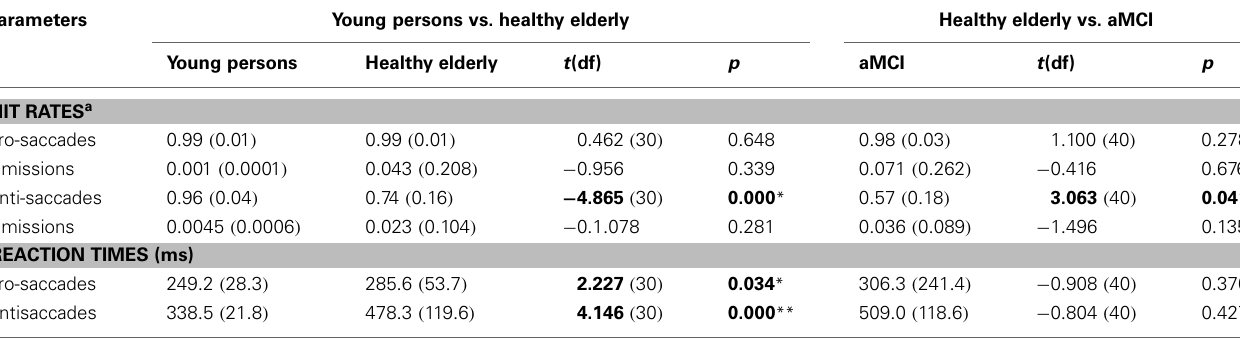
Table 3 | Performance measured outside of the scanner (proportion correct among executed saccades, proportion of omissions, reaction times in ms) of young persons, healthy elderly and aMCI patients in pro-saccade and anti-saccade